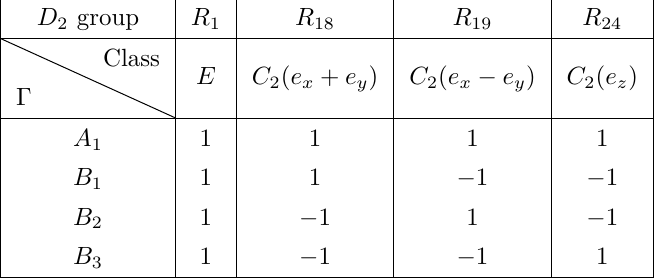
Table 9 . Character table for the D 2 group. The group elements R i are listed in table 5.